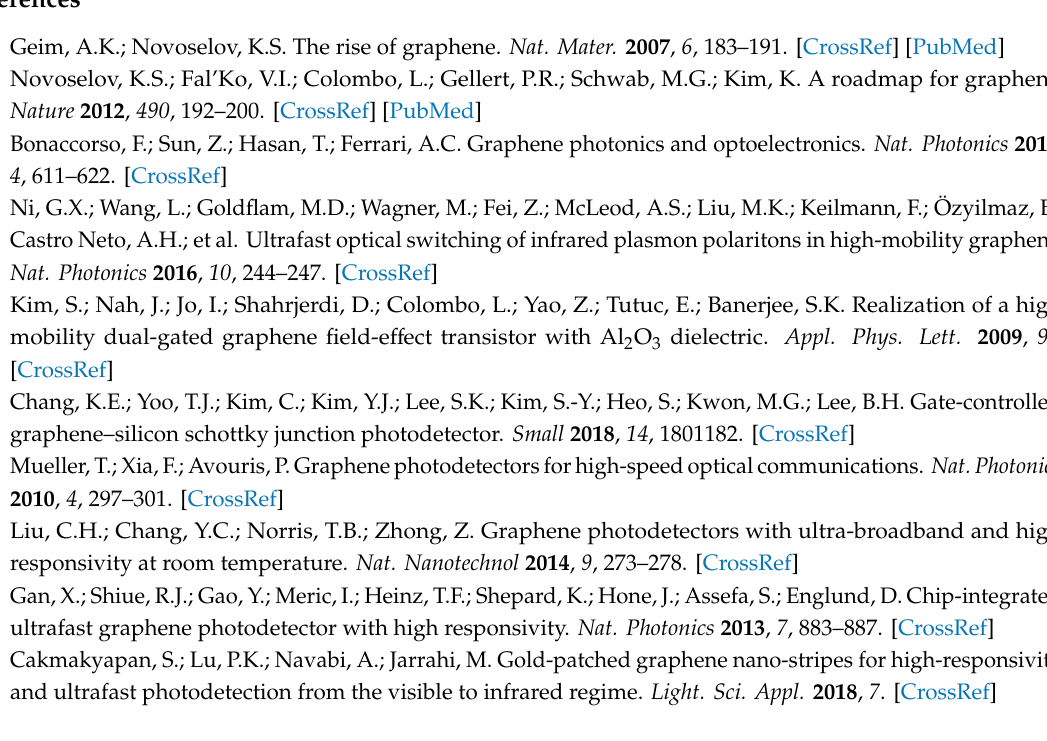
Figure S1: the hysteresis characteristics of the 300 ◦ C-annealed graphene FETs with the channel lengths of 10 µ m and 20 µ